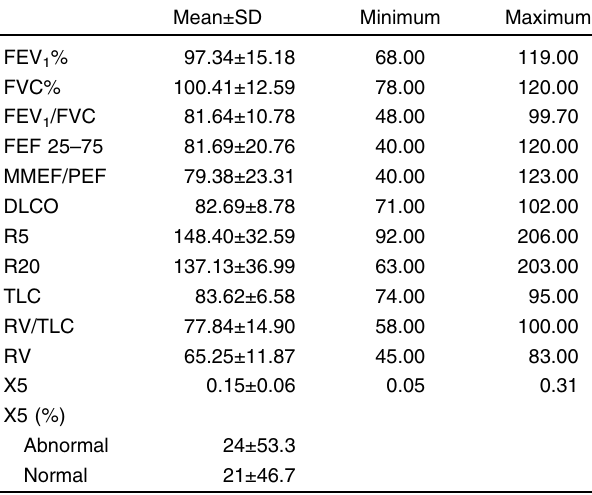
Table 2 Description of pulmonary function parameters among the studied cases